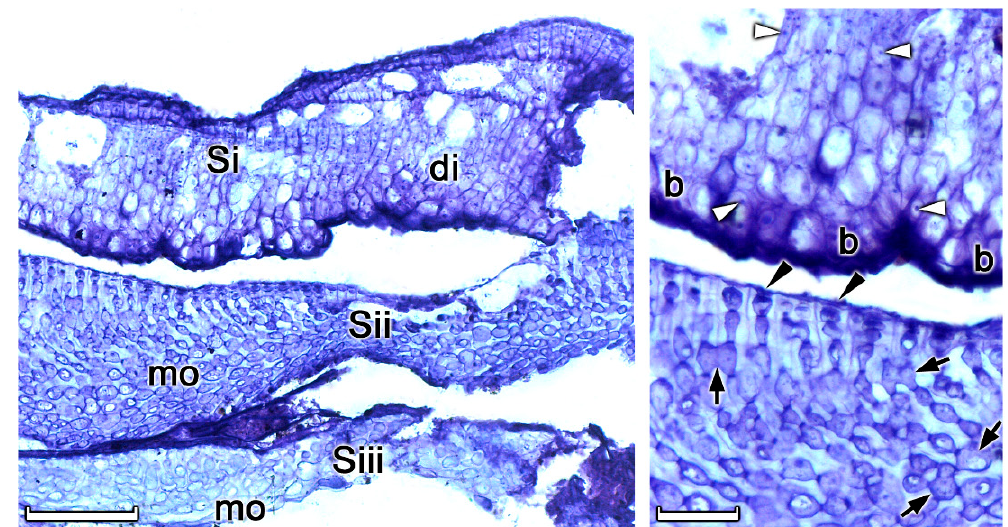
Figure 7. (Left and right) Three di ff erent living species growing in a superimposed manner (Si–Siii) on a single rhodolith (sample 15E). The outer crust (Si) belonging to the genus Lithophyllum had a dimerous thallus construction (di) with a single basal layer (b) of non-palisade cells and with secondary pit connections (white arrowheads) between cells of adjacent filaments. The middle crust (Sii) belonging to the genus Lithothamnion with senescent multiporate conceptacles (not evident in these images) had a monomerous thallus construction (mo), flared epithallial cells (black arrowheads) and cell fusions (black arrows) between cells of adjacent filaments. The inner crust (Siii) was non-descript, although it possessed a monomerous thallus construction, rounded epithallial cells and cell fusions between cells of adjacent filaments. Scale bars: 100 µ m (left); 20 µ m (right).